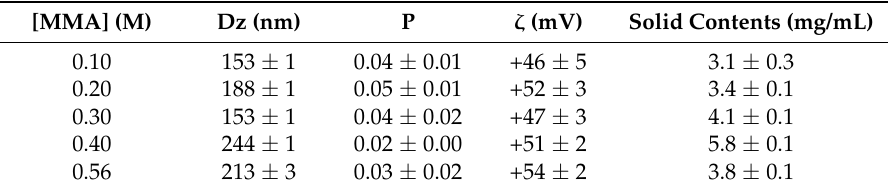
Figure 4. The effect of methyl methacrylate (MMA) concentration on conversion (%) of MMA into PMMA in the presence of PDDA (5 mg/mL) and AIBN (0.36 mg/mL) as initiator. The nanoparticles synthesis proceeded for 2 h at 70 to 80 °C and was followed by extensive dialysis before performing the dispersions characterization by dynamic light-scattering shown on Table 3. Table 3. Effect of MMA concentration on physical properties of the PMMA/PDDA dispersions obtained by emulsion polymerization of MMA at 5 mg/mL PDDA in 1 mM NaCl using 0.36 mg/mL of AIBN.